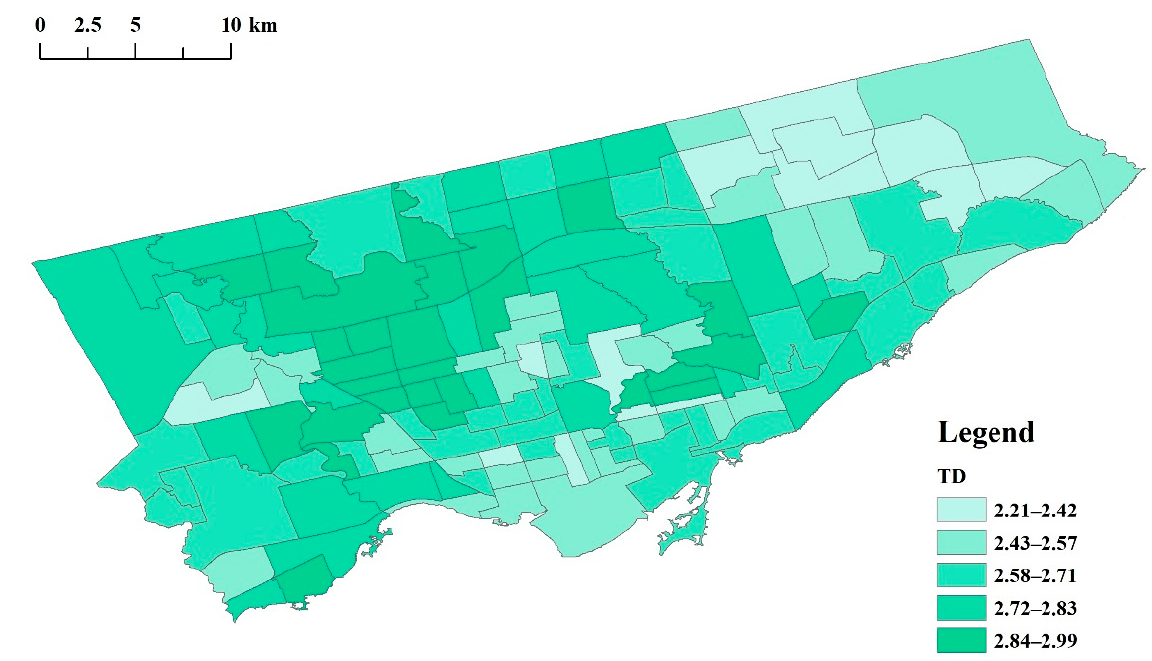
Figure A11. Distribution of tree diversity (TD).